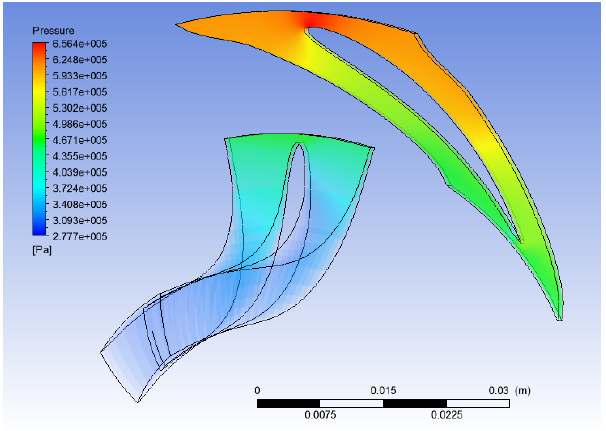
Figure 22. CFD study results: Pressure (R245fa).